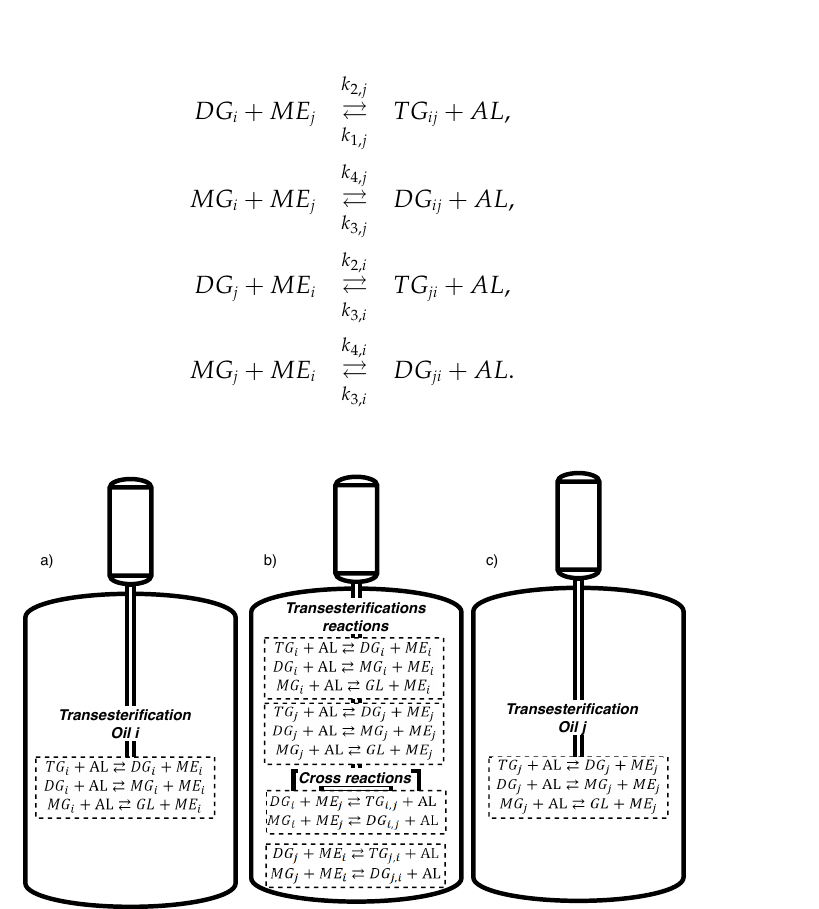
Figure 2. Different reactions occurring in the reactor: ( a ) nominal operation with a type-i oil; ( b ) transitory period after an oil change when two different transesterification processes and cross-linking reactions occur in the reactor tank; and, ( c ) nominal operation with a type-j